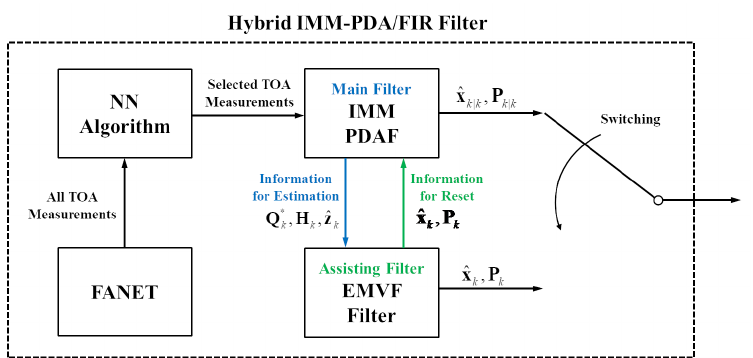
Figure 2. Block diagram of